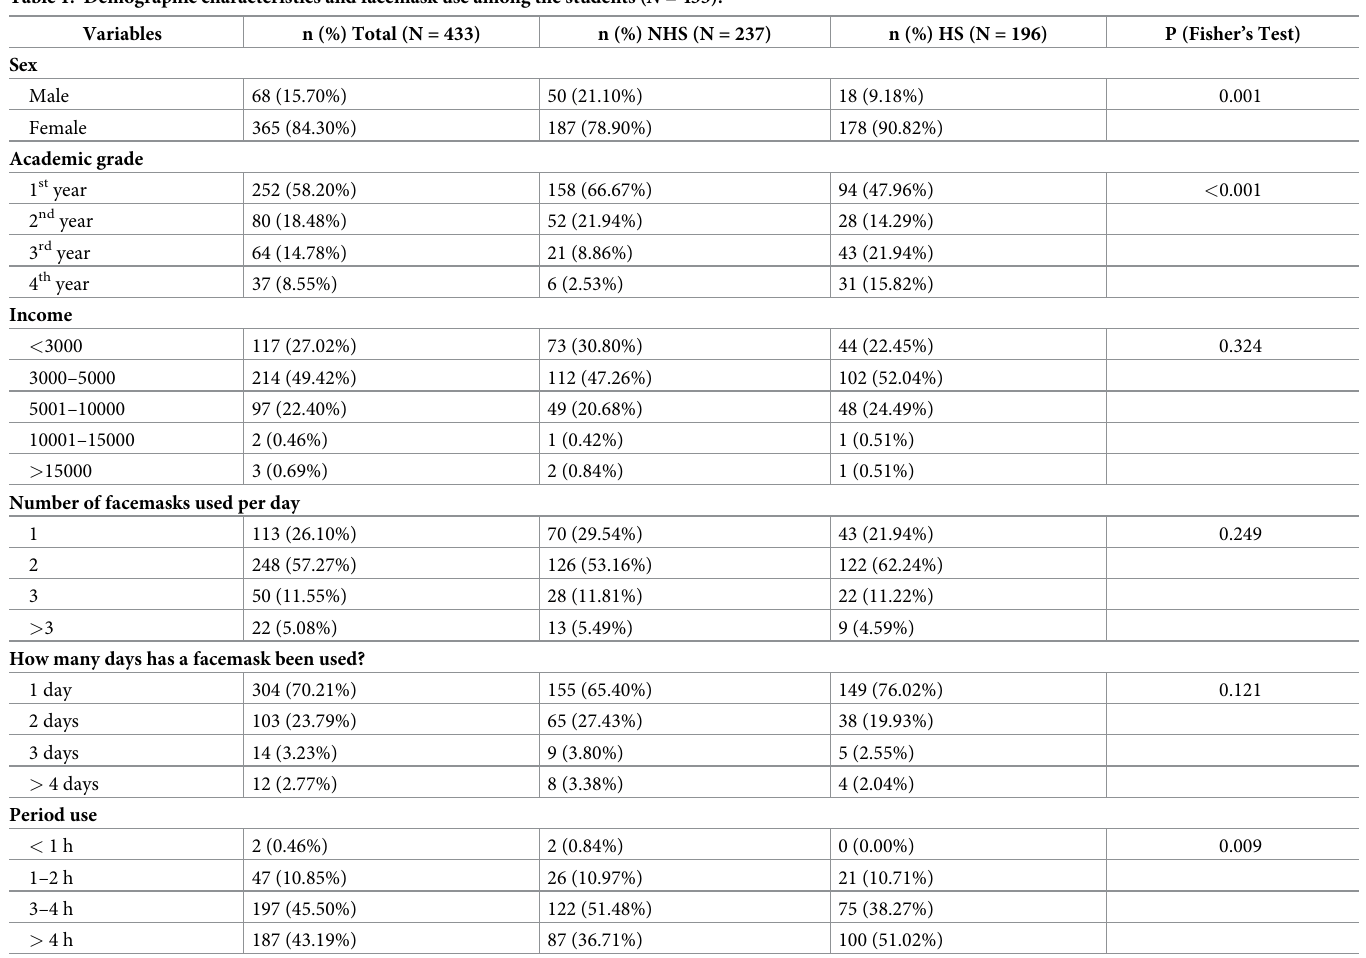
Table 1. Demographic characteristics and facemask use among the students ( N =